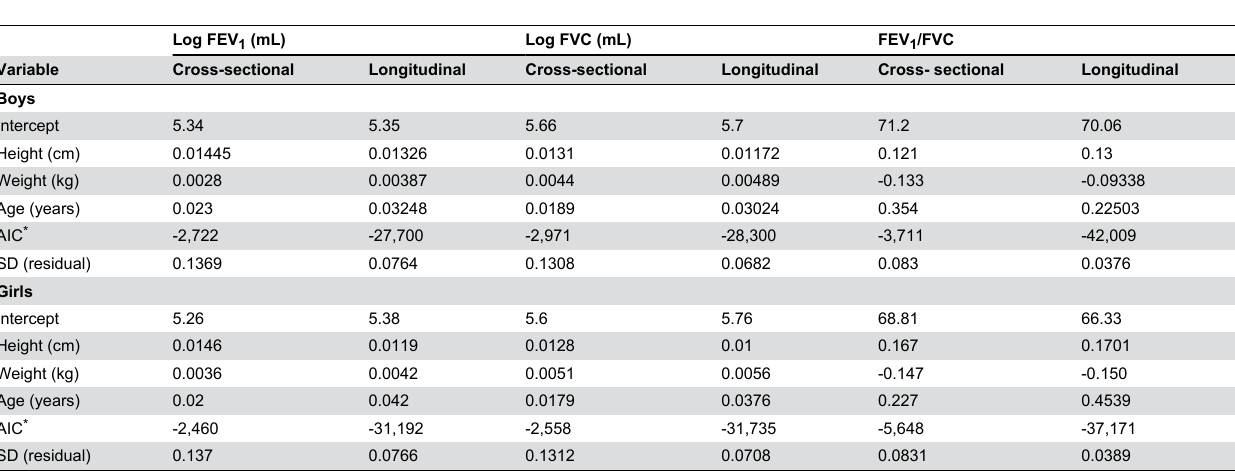
Table 4. Multiple regression equations for spirometric variables comparing cross-sectional predicted values and longitudinal models from the reported